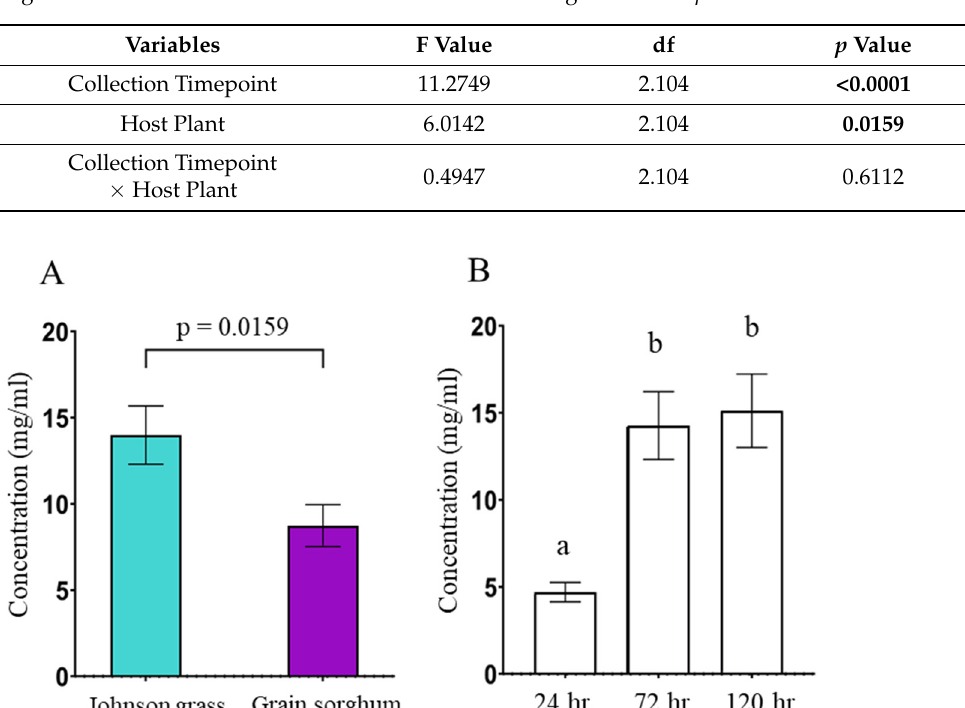
Table 1. Results from ANOVA Indicate that Timepoint and Host Plant Diet Affect Honeydew Total Sugar Concentration. Bolded Values Indicate Statistical Significance at p < 0.05.